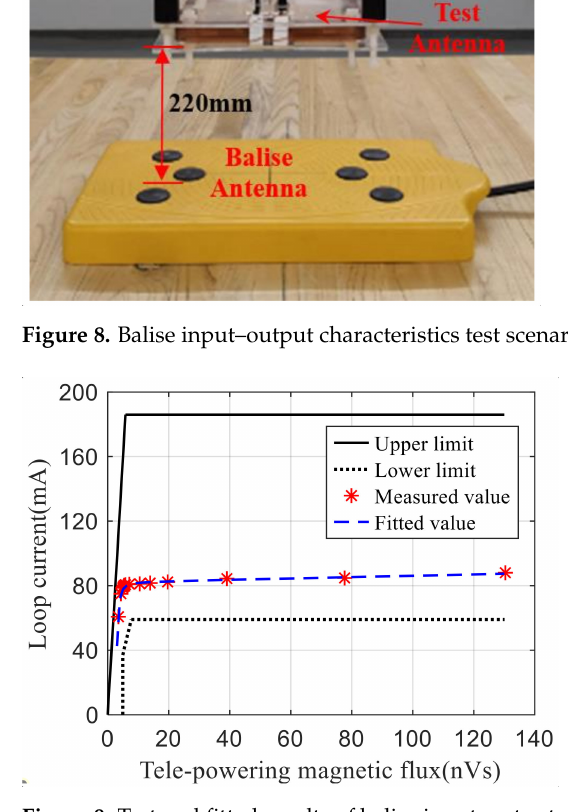
Figure 9. Test and fitted results of balise input–output